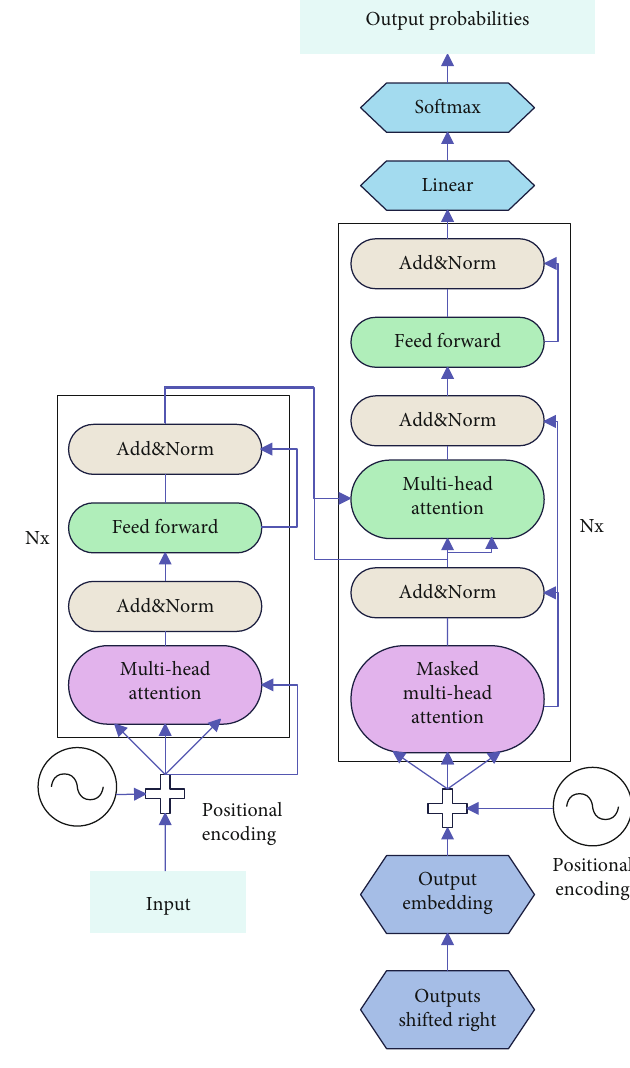
Figure 5: Transformer structure diagram.